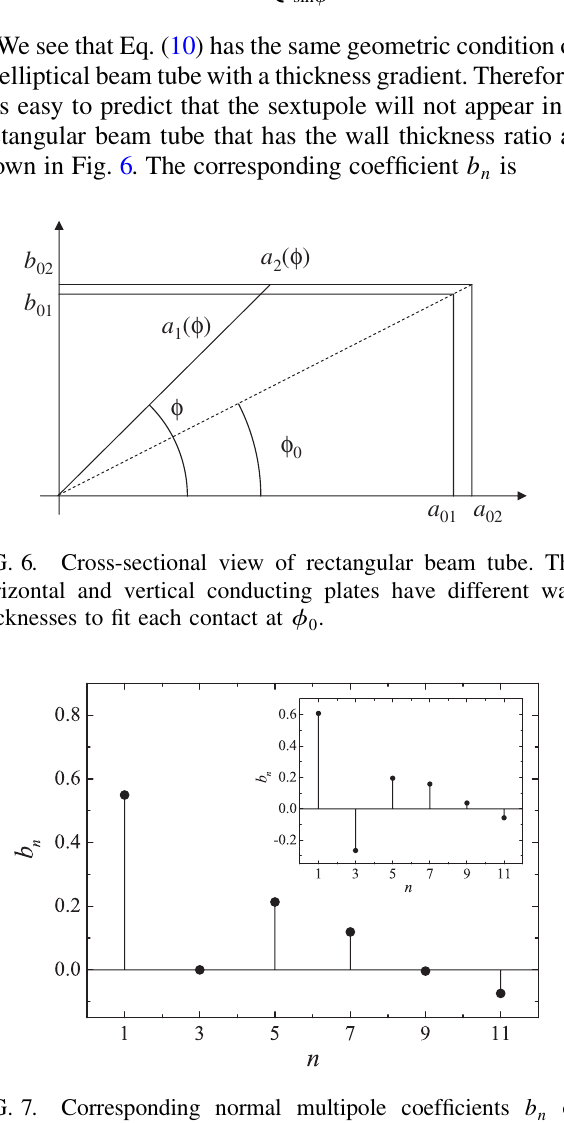
FIG. 7. Corresponding normal multipole coefficients b n of rectangular beam tube shown in Fig. 6. Even though the sextupole component is successfully removed, other multipoles still show noticeable magnitude compared to the dipole value. The inset shows the case of horizontal and vertical plates that have the same chamber wall thickness. It shows that all multipole re- sponses are considerably higher than that of an elliptic beam